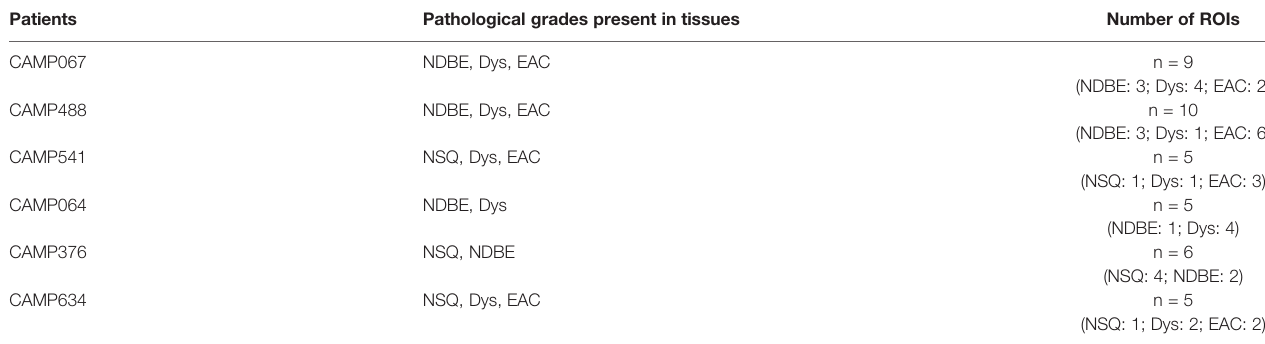
TABLE 2 | EMR sample cohort and ROI